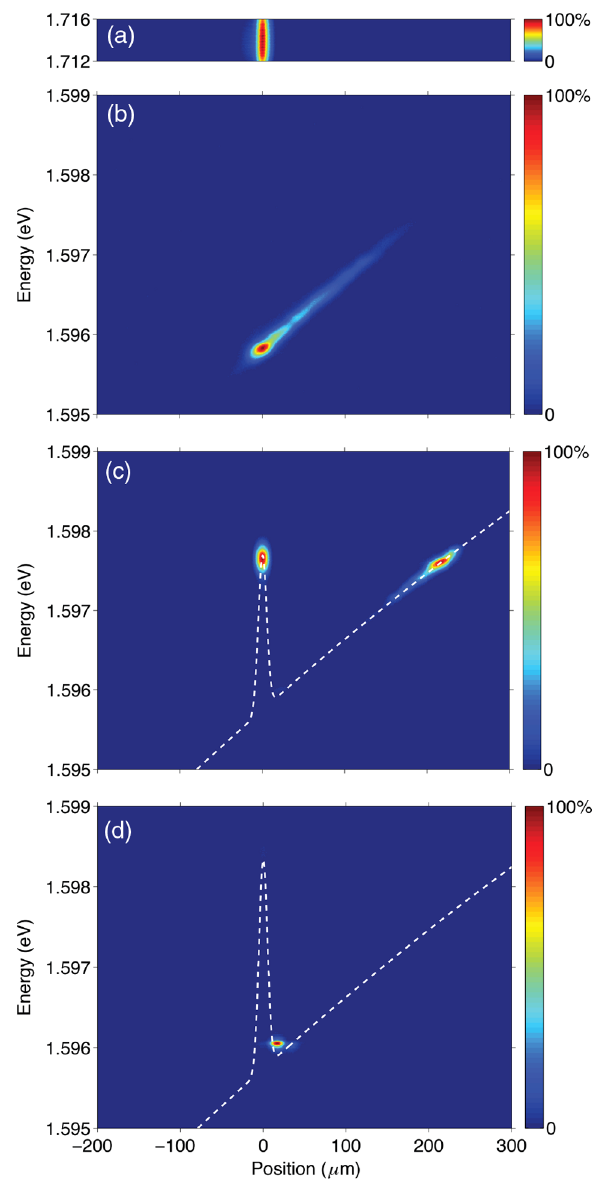
FIG. 2. Real-space images of the polariton motion, for the same conditionsas the data ofFig.1, but restricted to k k ’ 0 ( (cid:2) 2 (cid:3) angle of acceptance). (a) The hot carrier luminescence created by the laser-excitationspot,inthelow-densitylimit(1-mWpumplaserina spot of radius 12 (cid:2) m ). This luminescence profile shows the spatial extent of the excitation region where the polaritons are generated and the exciton cloud that remains at the point of creation. (b) Real- space image of the polariton emission at 1-mW pump power. (c) 34 mW. (d) 44 mW. The dashed white lines show the calculated potential-energy profile felt by the polaritons, which is the sum of the effects of the slope due to the cavity-width gradient and the localized exciton cloud at the laser-excitation